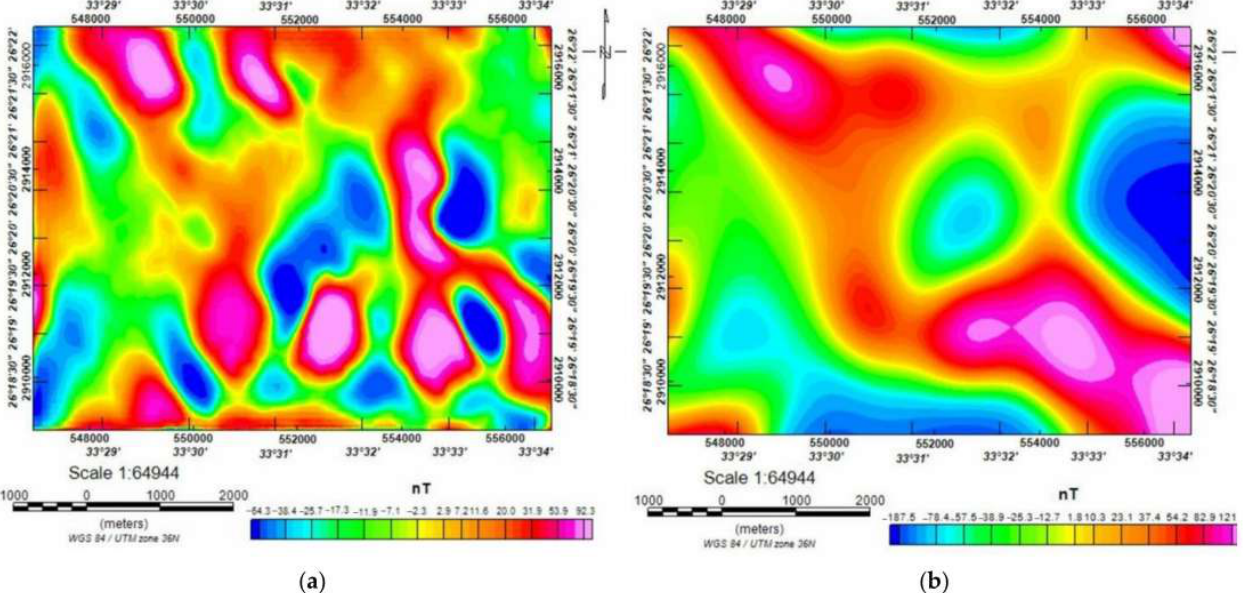
Figure 7. ( a ) High-pass-filtered (residual) map of the study area. ( b ) Low-pass filtered (regional) map. Deep-seated magnetic abnormalities can be seen on the regional (low-pass) magnetic map (Figure 7b). Deep structural patterns in the NW–SE, NE–SW, N–S, and E–W axes impact the region. The values of these magnetic anomalies range from 121.2 to − 187.6 nT. Low magnetic anomalies (green and blue colors) are connected to the sedimentary cover and weakly deformed calc–alkaline rocks, and they extend in NW–SE and E–W directions. High magnetic anomalies (yellow, red, and pink colors) are related to the presence of the ophiolitic assemblage and metavolcanic rocks, and they extend in NE–SW and S–N